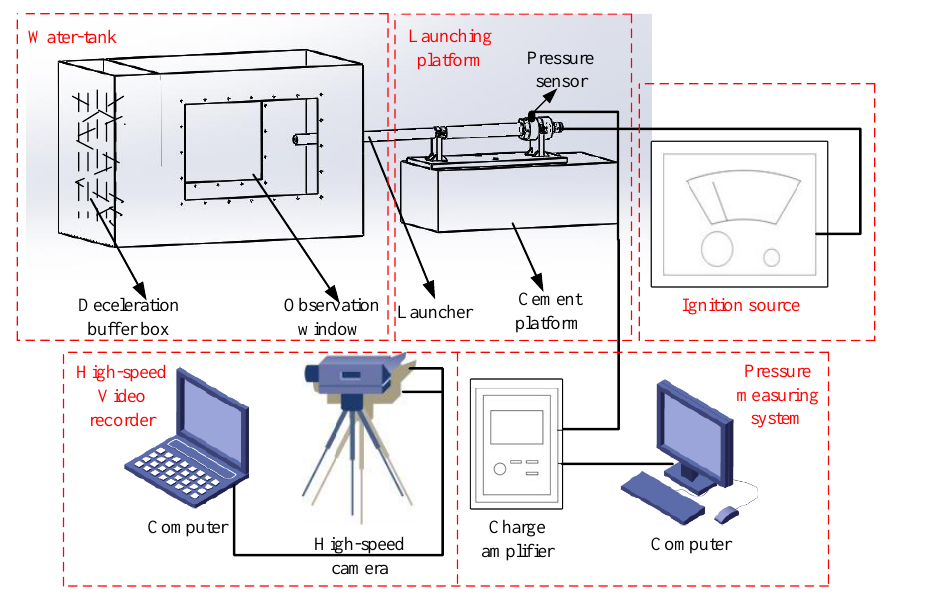
Figure 1. Schematic diagram of the experimental system.